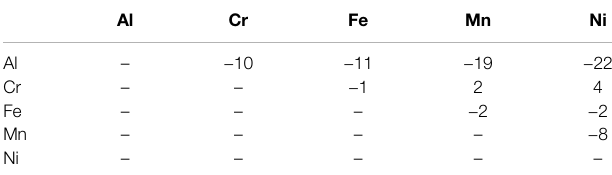
TABLE 4 | Mixing enthalpy of principle elements (kJ/mol) (Takeuchi and Inoue, 2005).